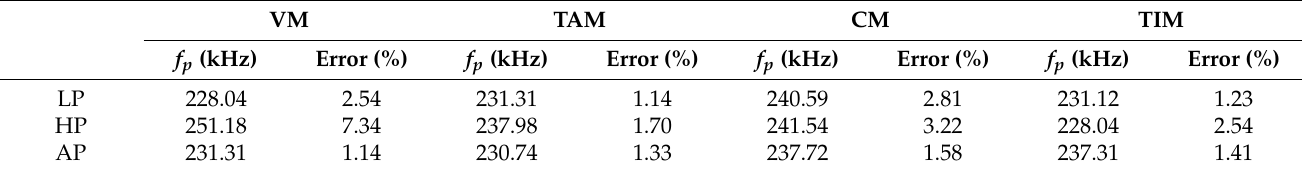
Table 6. Measured f p and percentage errors of the proposed filter in Figure